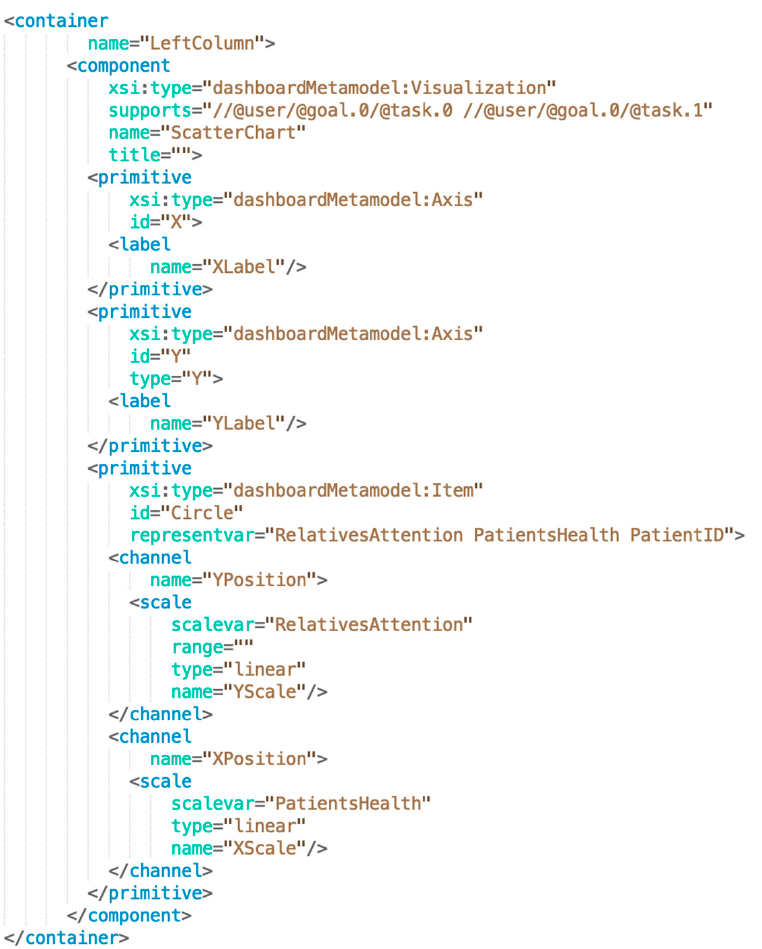
Figure 9. Fragment of the Extensible Markup Language (XML) metadata interchange (XMI) instance file containing the information regarding the scatter chart component of the dashboard.